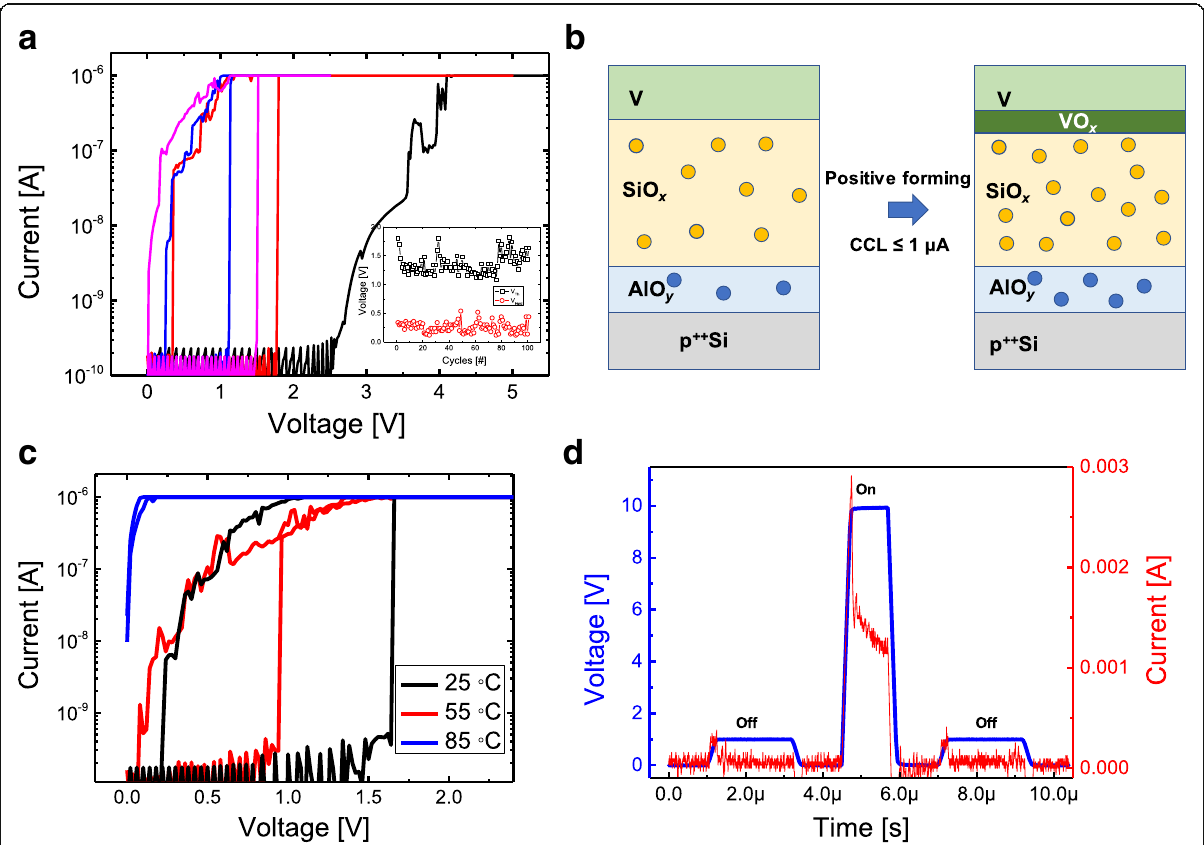
Fig. 2 Unidirectional threshold switching of V/SiO x /AlO y /p ++ Si when a positive forming with CCL of 1 μ A is applied. a Typical I – V curves. b Schematic drawing of forming process. c I – V characteristics by temperature dependence. d Transient